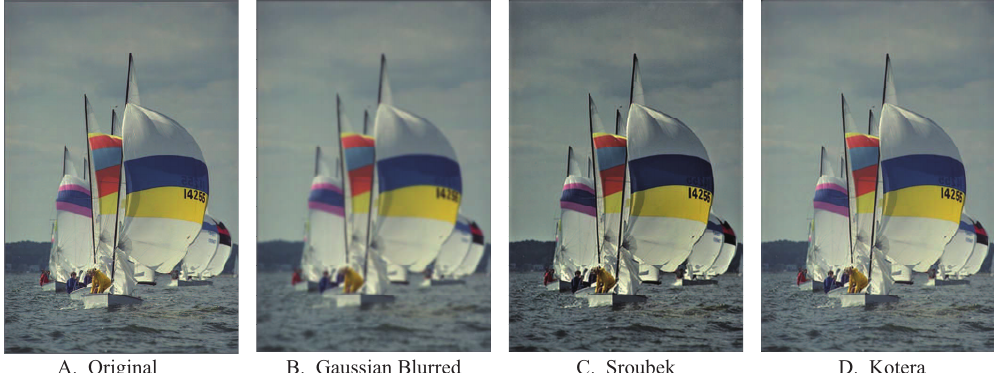
Figure 9. Group 1 restorations: The original image is 480 × 720 × 3 which is provided by LIVE II dataset while the blurred image is produced by a Gaussian low-pass filter of 11 × 11 with deviation 1.5. The restorations are produced by Sroubek [30] and Kotera [31], respectively.